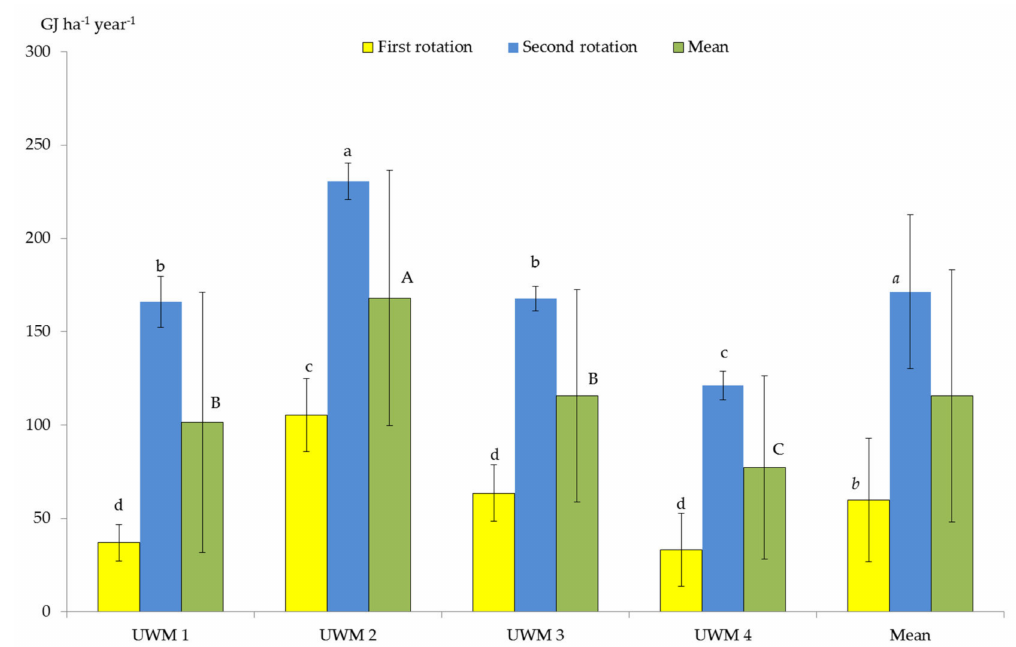
Figure 1. Yield energy value of four poplar clones in two consecutive 4-year harvest rotations converted to one year of the plantation use. A.B.C ... homogenous groups for clone; a.b ... homogenous groups for rotation; a.b.c ... homogenous groups for clone x rotation interaction; error bars represent standard